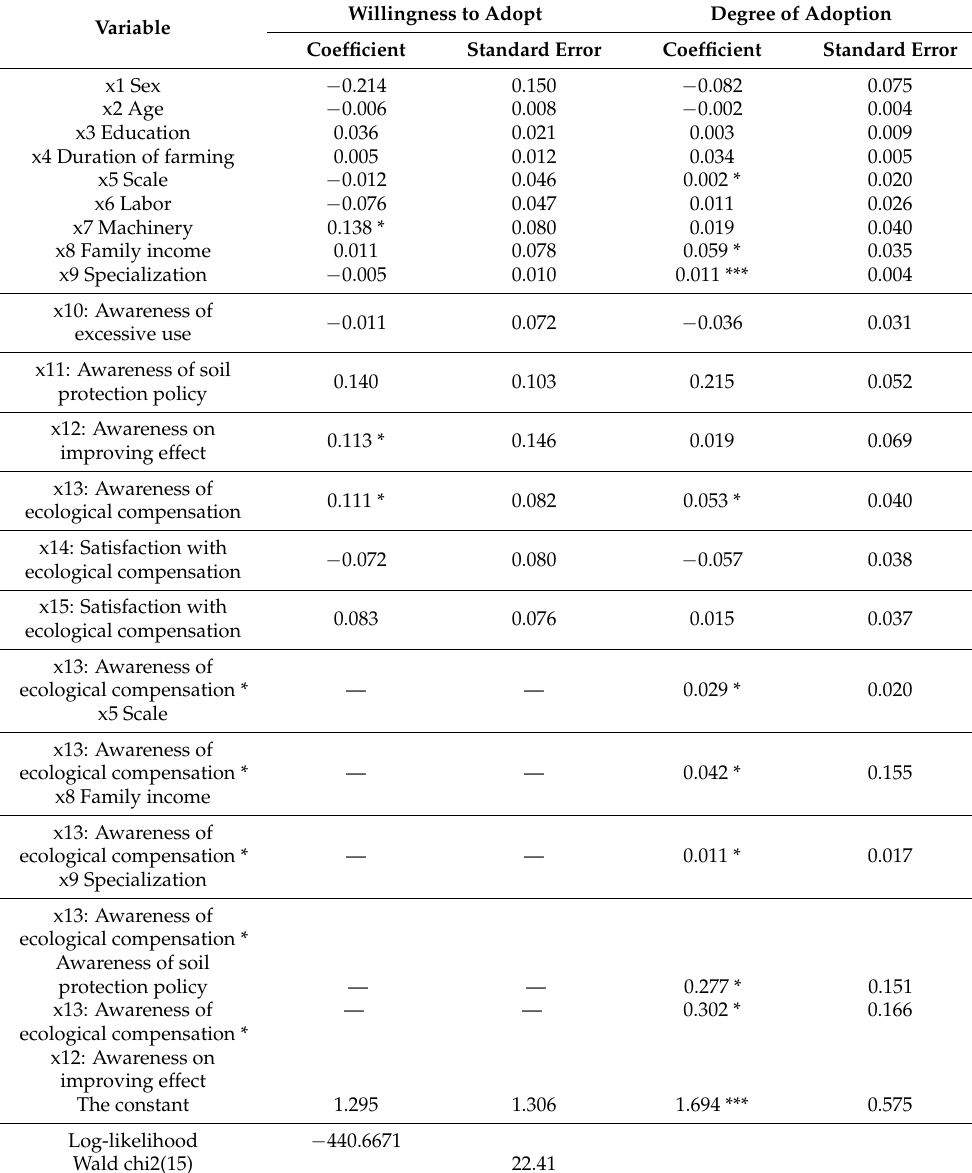
Table 2. Model regression